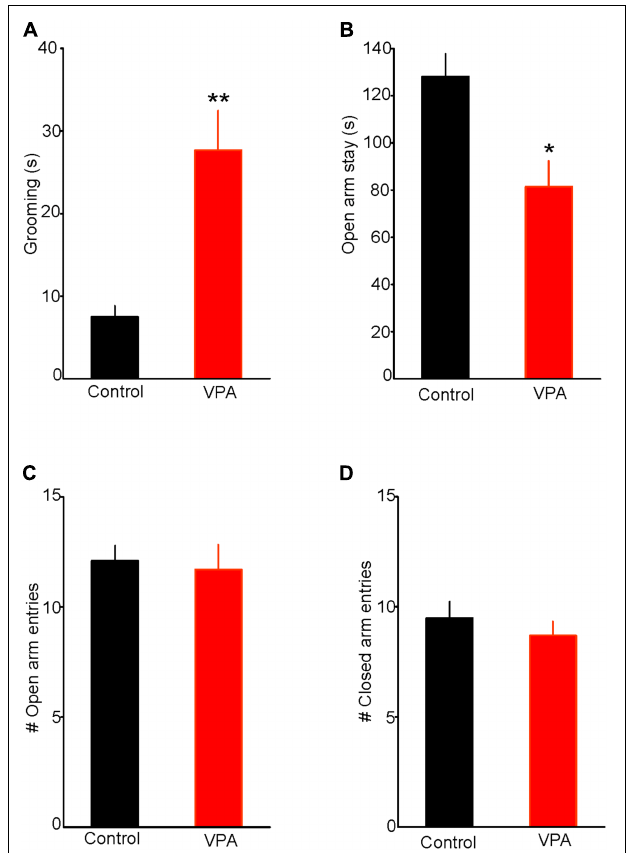
FIGURE 1 | Prenatal valproic acid (VPA) exposure increases anxiety-like behaviors. (A) Effect of prenatal VPA exposure on self-grooming. Note the significant increase in duration of self-grooming in VPA rats, indicating augmented anxiety (Control: n = 7; VPA: n = 8, p < 0.01). (B) Effect of prenatal VPA exposure on the duration of open arm stay in the elevated plus maze. Note the significant reduction in open arm stay in VPA rats (Control: n = 10; VPA: n = 7, p < 0.05). (C,D) illustrate the effects of prenatal VPA exposure on the numbers of open and closed arm entries, respectively. Note that prenatal VPA exposure does not alter the numbers of entries into the open or closed arms (Control: n = 10; VPA: n = 7; p > 0.05 for both). Data are presented as Mean ± SEM. ∗ p < 0.05; ∗∗ p <